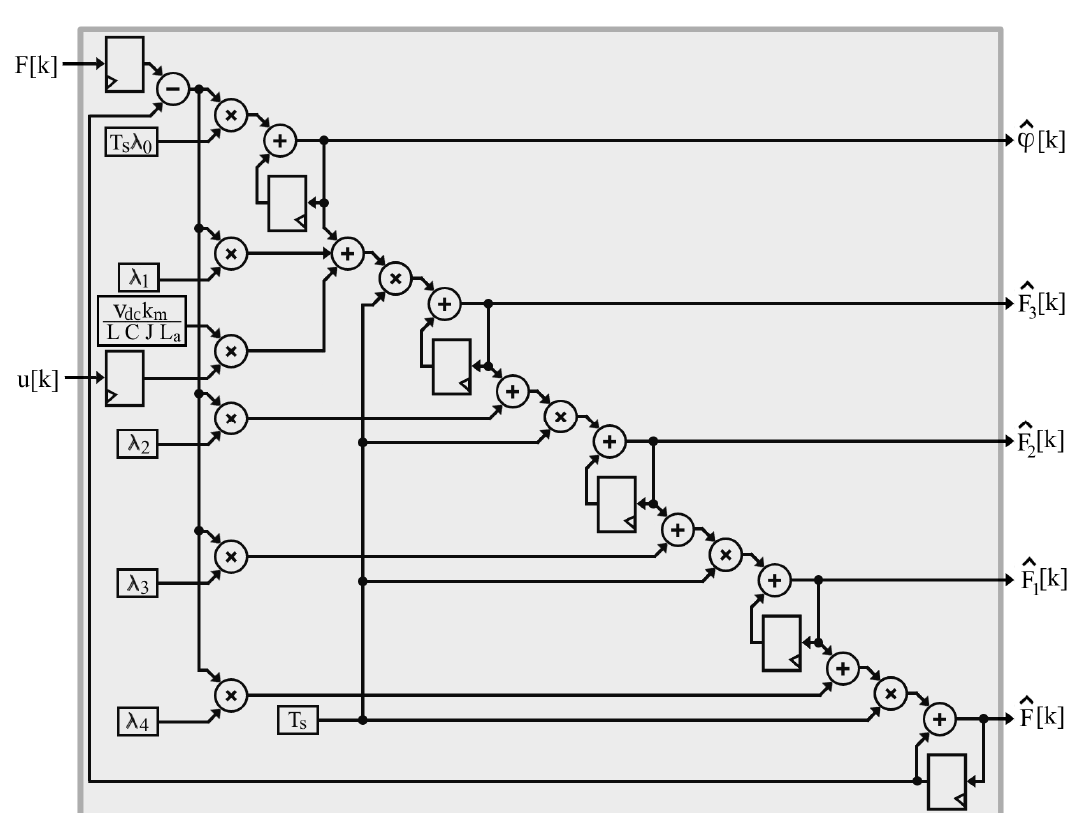
Figure 10. Implementation of the GPI observer module that estimates the disturbances.